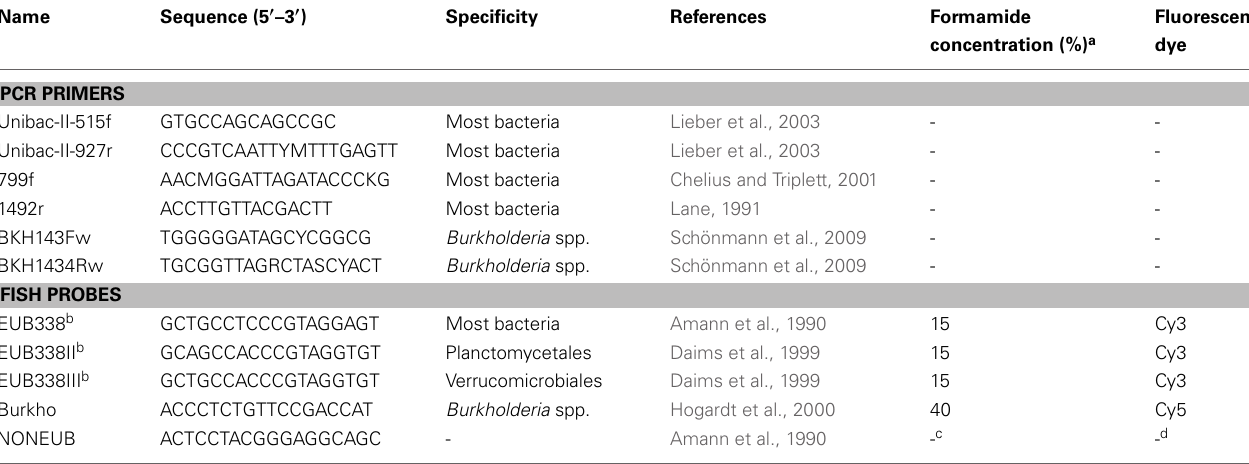
Table 1 | Nucleotide probes used for the PCR and